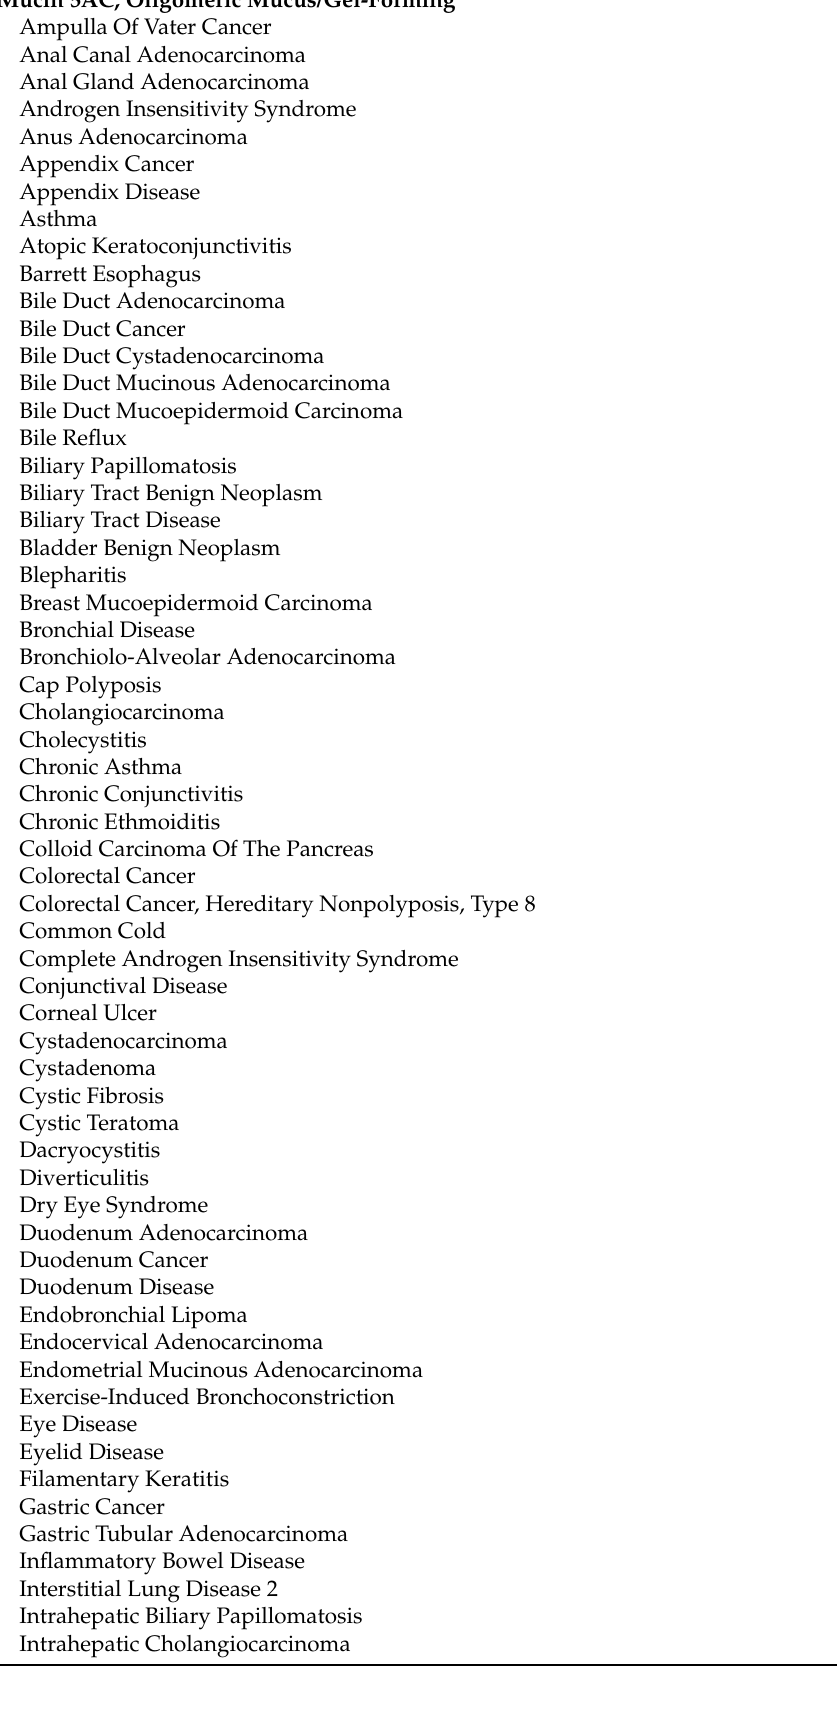
Table A1. Cont. Mucin 5AC, Oligomeric